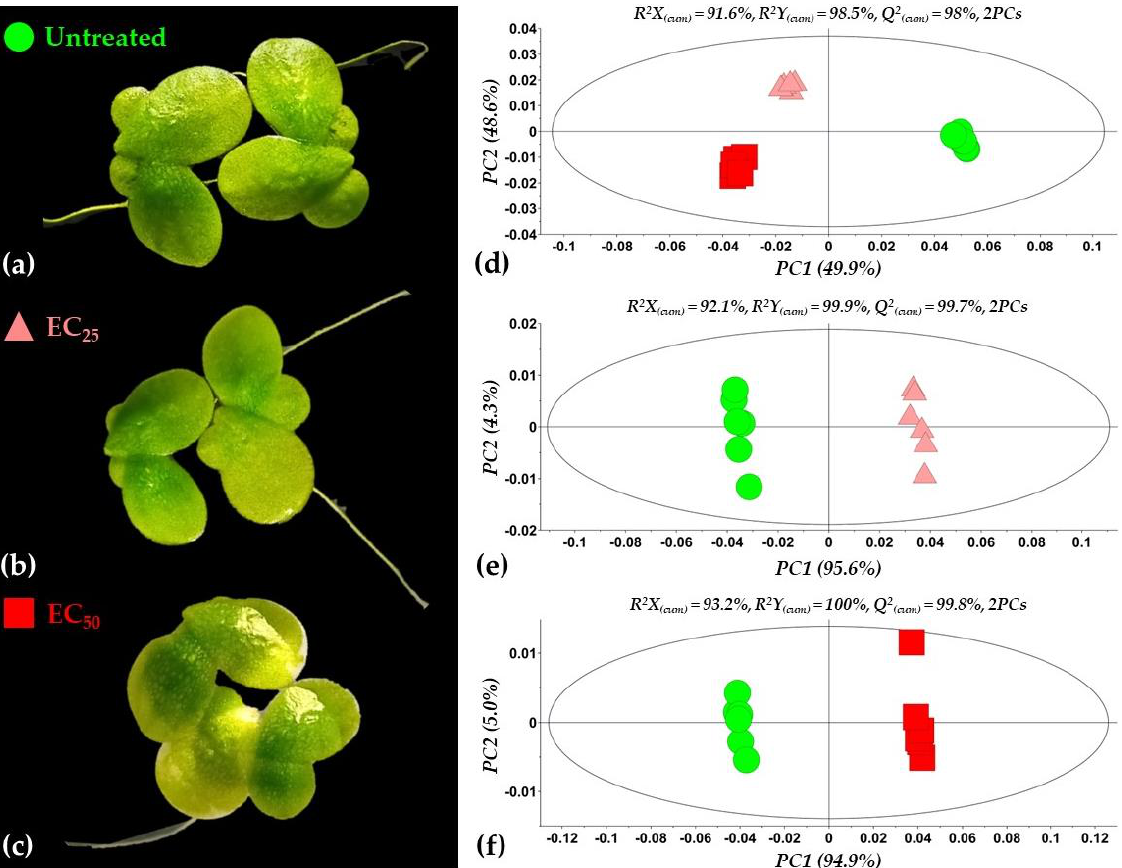
Figure 3. Effect of the Bacillus sp. PTA13 lipopeptide extract on the phenotypes of Lemna minor L. ( a – c ) and the corresponding GC/EI/MS metabolite profiles ( d – f ). The plants were exposed to concentrations equal to the EC 25 (156 µ g · mL − 1 ) and EC 50 (419 µ g · mL − 1 ) of the extract and analyses were performed 72 h following exposure. Both treatments resulted in a slight discoloration of the plants’ fronds ( b , c ). The metabolite differences between the untreated and the lipopeptide-treated plants were analyzed applying orthogonal partial least squares discriminant analysis (OPLS-DA). OPLS-DA PC1/PC2 score plots are displayed with 95% confidence interval. The ellipse represents the Hotelling’s T 2 . In total, fifteen biological replications of two plants each were performed per treatment, every three of which were pooled to provide a pooled sample. Five pooled and one quality control samples were analyzed per treatment [PC; principal component, Q 2 (cum) ; cumulative fraction of the total X ’s variation that can be predicted, R 2 X and R 2 Y; fraction of the sum of squares of X ’s and Y ’s explained by the components,